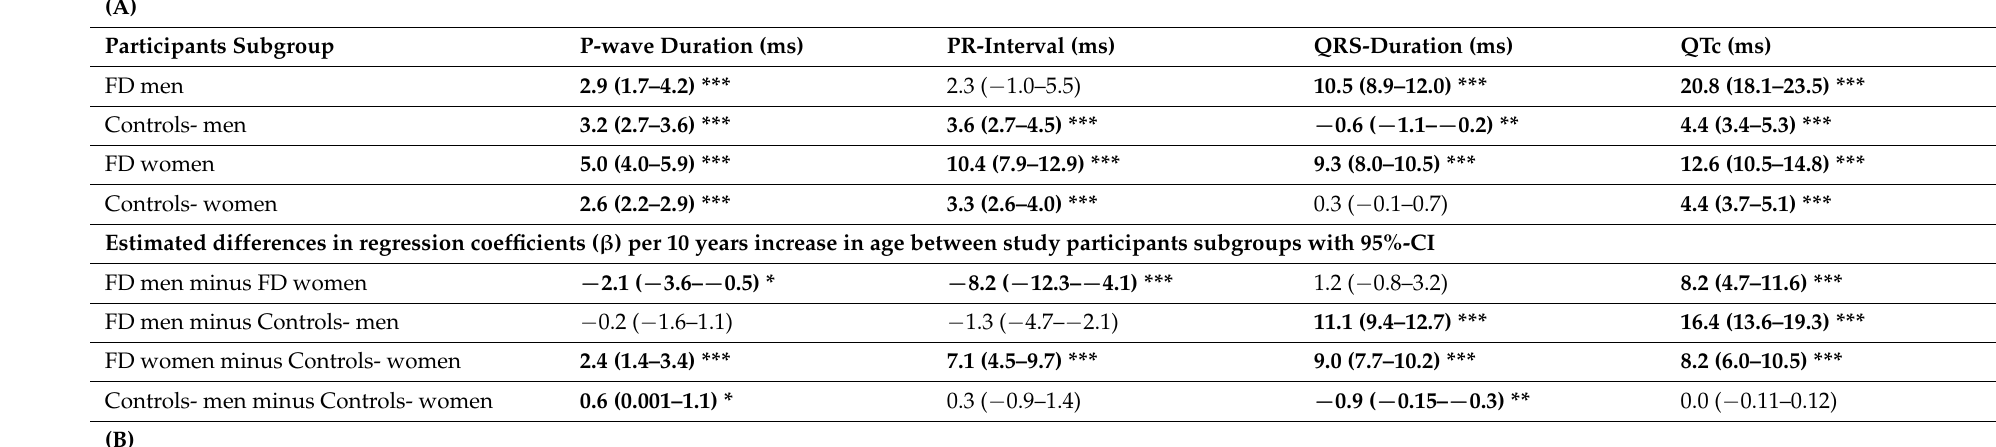
Table 2. Estimated regression coefficients ( β ) per 10 years increase in